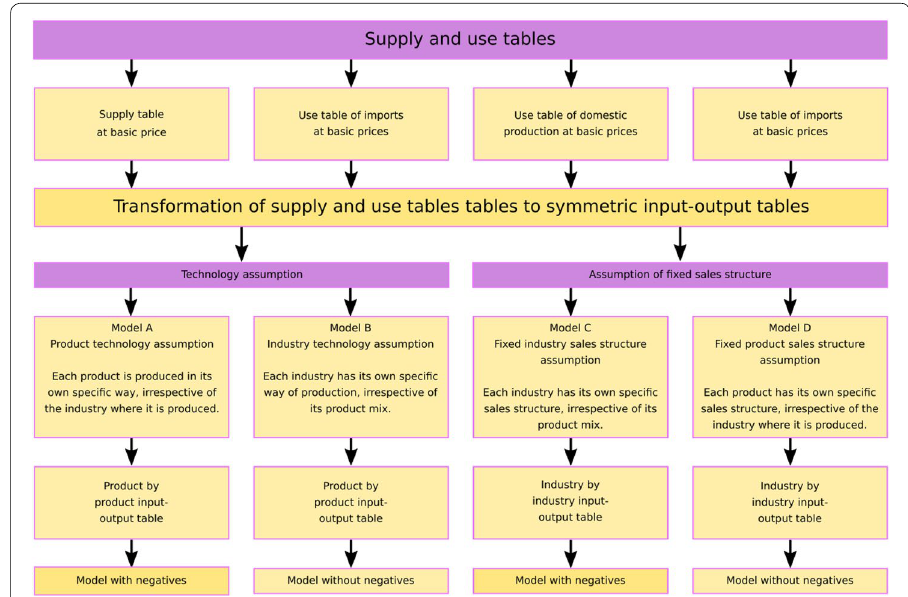
Fig. 1 Transformation of supply and use tables to symmetric input–output tables. Simplified after Eurostat (2008, p.